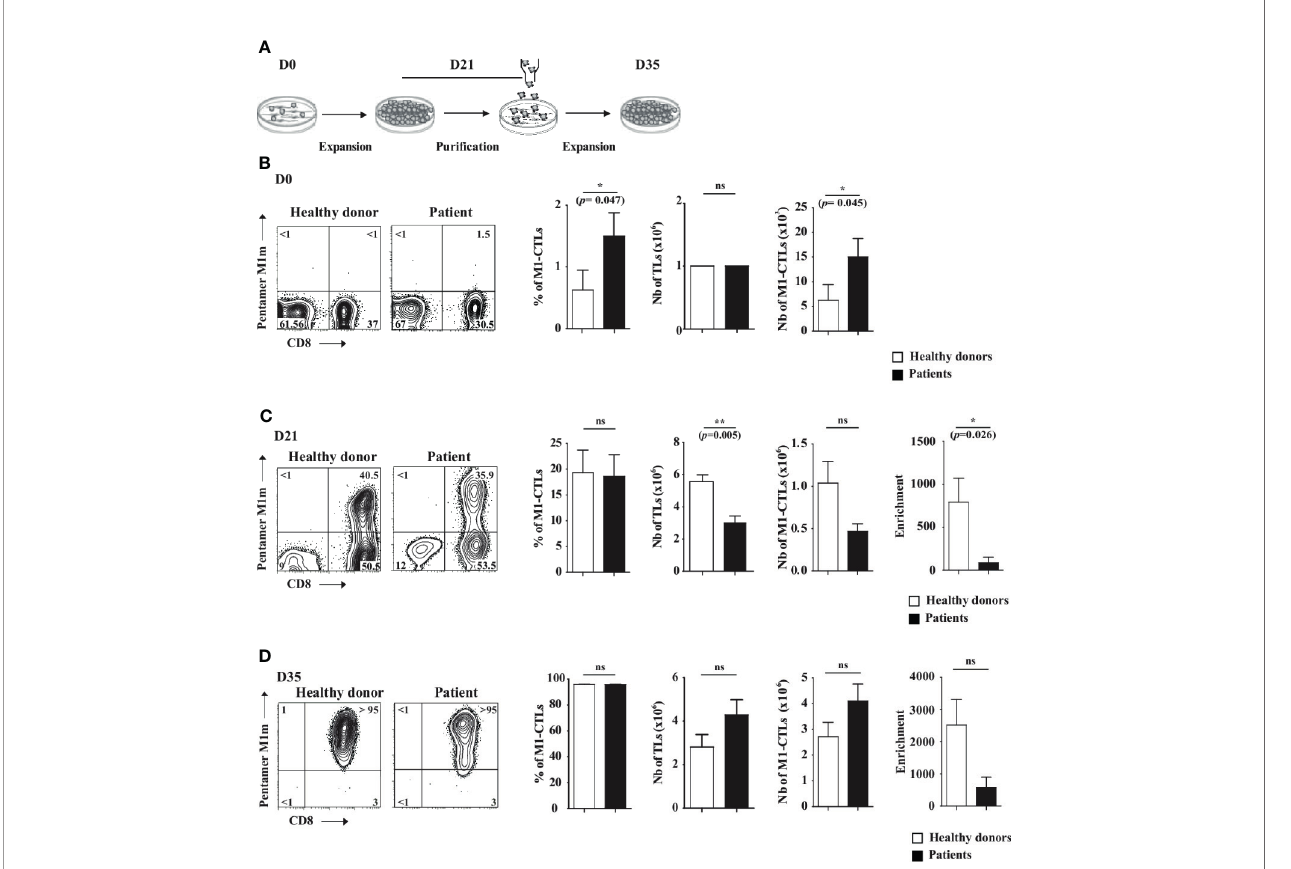
FIGURE 1 | AAPC-based protocol to obtain pure MART-1-speci fi c cytotoxic T lymphocytes. (A) Scheme describing the NIH/3T3-derived AAPC-based protocol in three steps: fi rst, at day (D) 0 of the co-culture, total TLs were co-cultured with irradiated AAPC M1m . At D21, MART-1-speci fi c cytotoxic TLs (M1-CTLs) were puri fi ed by magnetic sorting and expanded until D35. (B – D) At D0 (B) , D21 (C) and D35 (D) , MART-1 expression was assessed using PE-labeled Pentamer and APC- labeled anti-CD8 (left parts). Histograms of M1-CTL percentages, TL absolute numbers and M1-CTL absolute numbers respectively (right parts) are displayed. Left parts. Representative examples of patients and healthy donors are displayed. Quadrants are placed according to isotype control staining. Relative percentages are shown in each quadrant. Right parts. Histograms were obtained from ten healthy donors (white bars) and six patients (black bars) and shown with standard errors of means. Statistical tests ( t test) were performed to compare both groups. Not signi fi cant (ns): p > 0.05, * p < 0.05, **p < 0.005